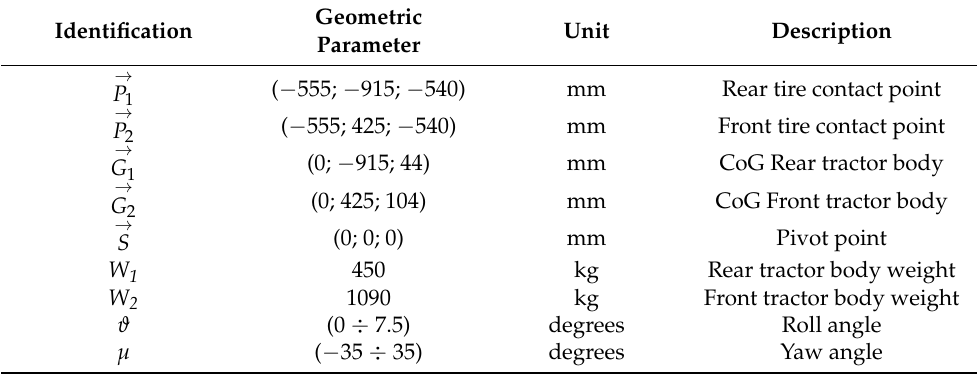
Table 1. Input tractor parameters.